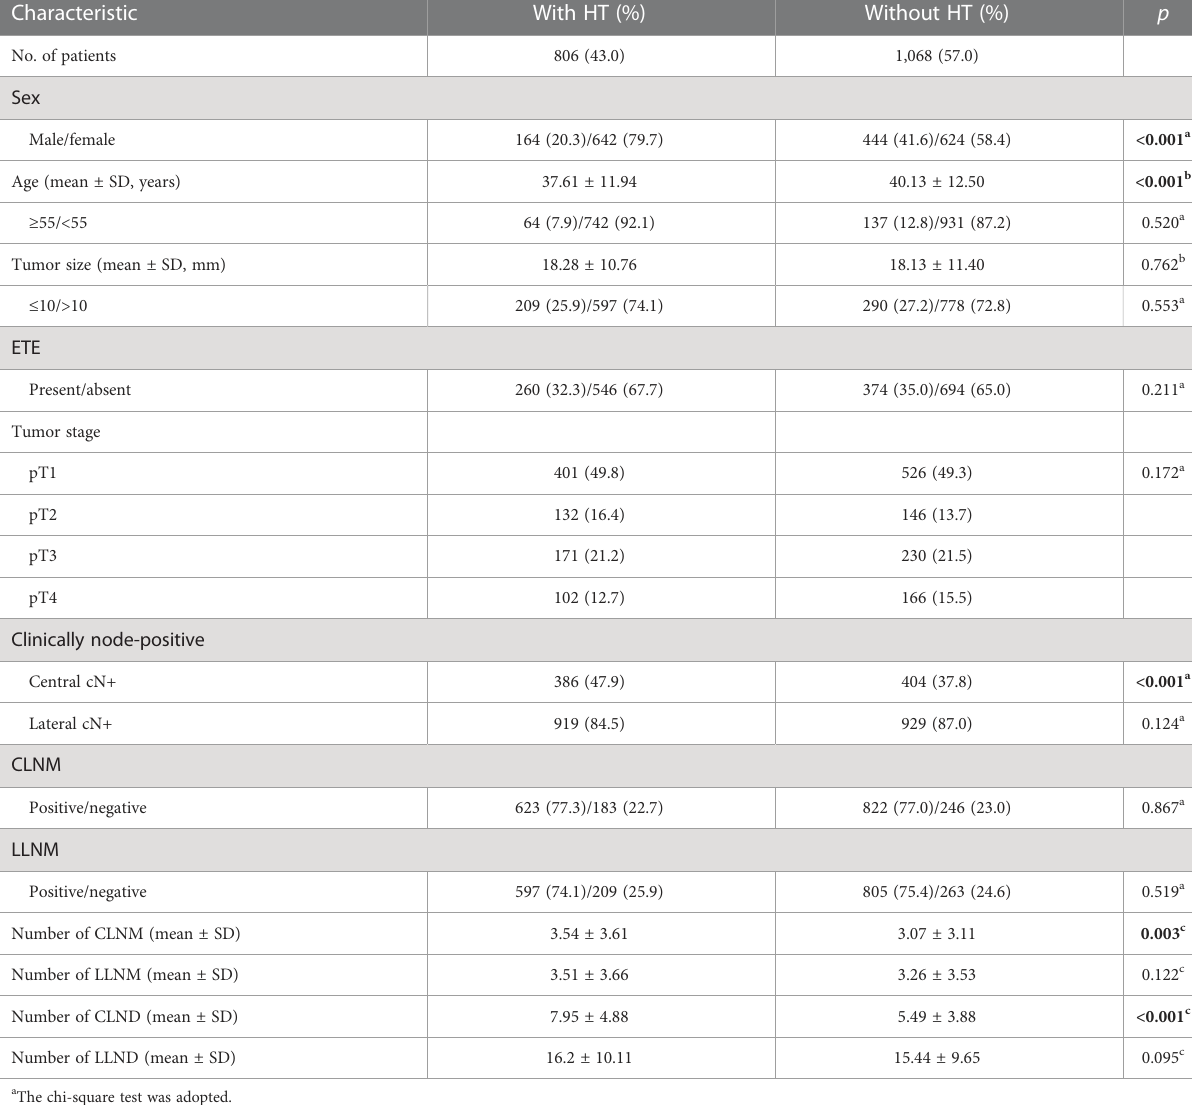
TABLE 1 Comparison of the clinicopathological characteristics of PTC patients with HT and without HT.